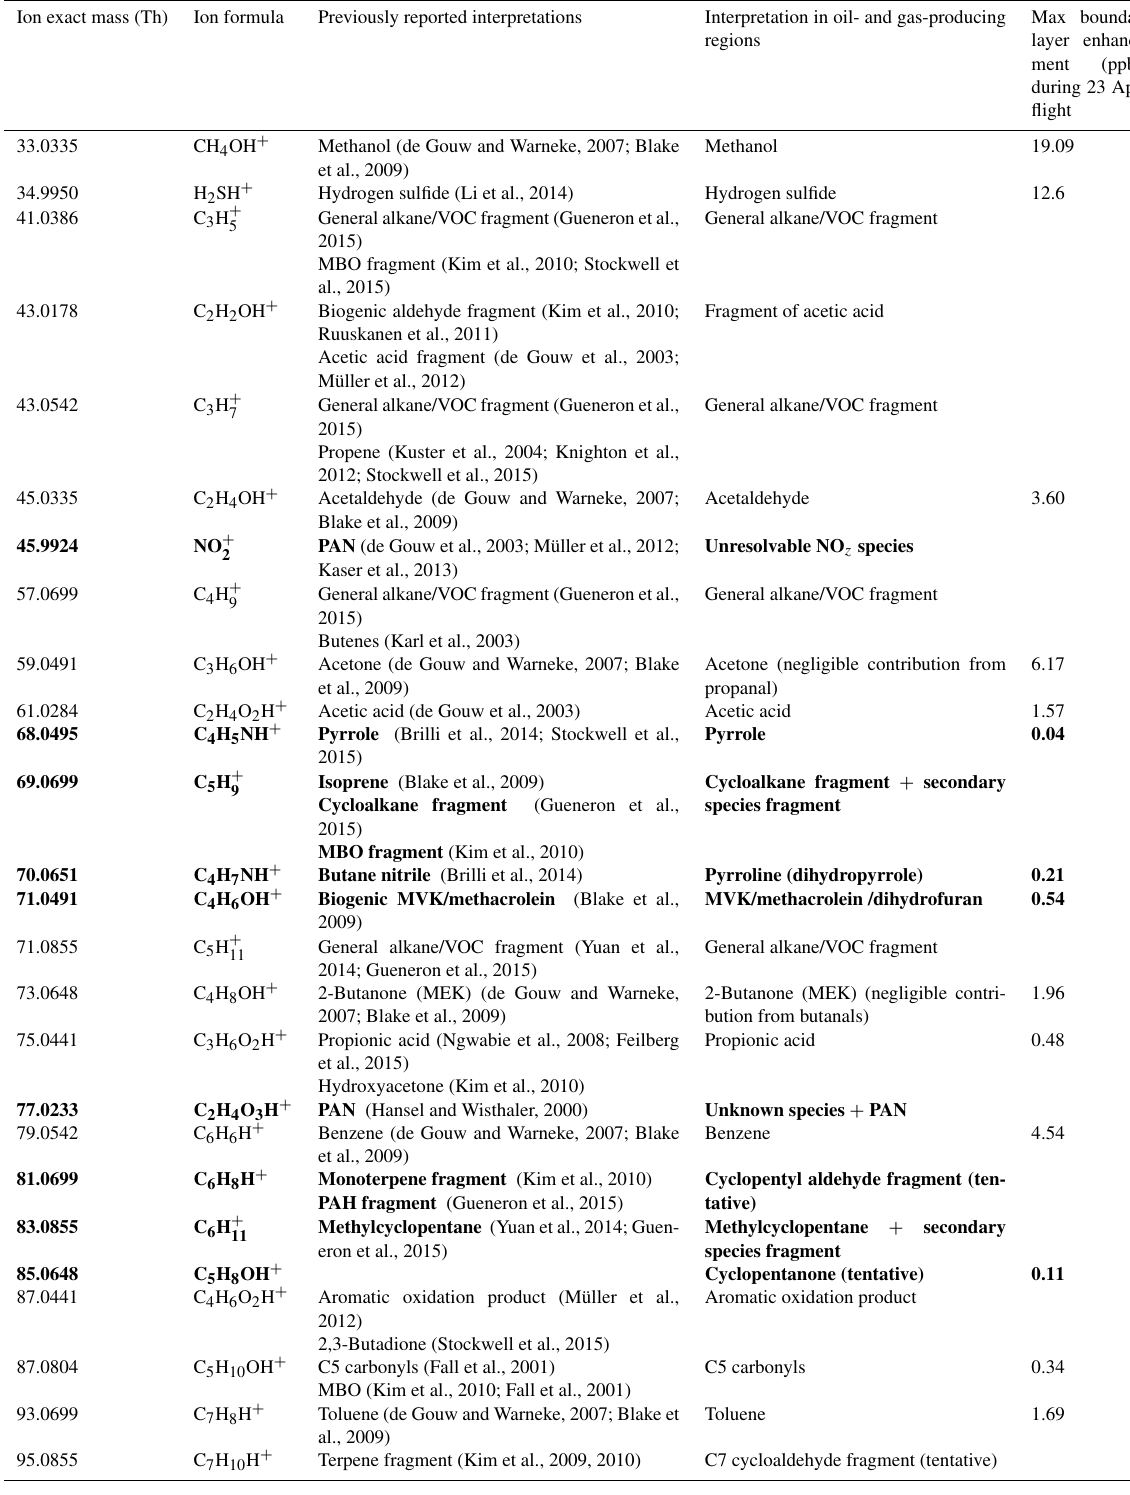
Table 2. Significant ion masses and interpretation. Mixing ratio (ppbv) enhancements are listed only for non-fragmentary ions of relatively certain identification. Ion masses with VOC interpretation of particular interest are highlighted using bold